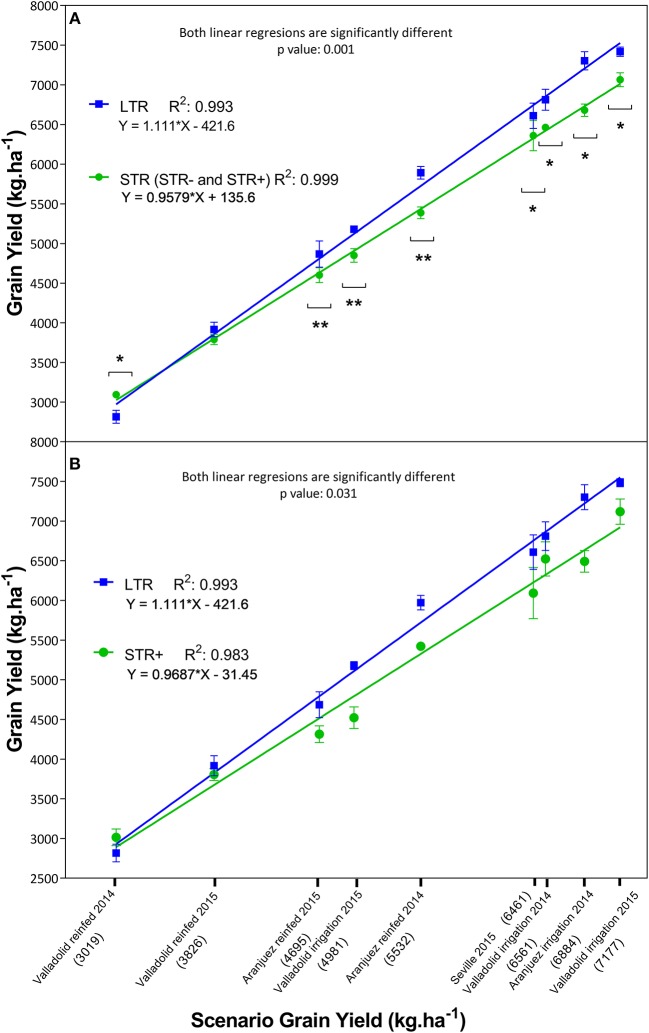
Grain yield differences between the segmented transpiration (STR: including less segmented transpiration, STR−and very segmented transpiration, STR+) and linear transpiration (LTR) lines across nine different growing conditions in the field. The X-axis presents the mean yield values of the complete set of 20 lines within each of the 9 trials where the mean yield across lines is expressed within parentheses below the name of the trial, while the Y-axis exhibits the mean yield of each subset of lines. In (A) the linear regressions represent the grain yield of the LTR (blue squares) and STR (green circles) groups within each growing scenario. Asterisks indicate significant differences between the LTR and STR groups performed by ANOVA (*p < 0.05, **p < 0.01). In (B) the linear regressions represent the average grain yield of the complete set of STR+ and LTR lines. Each value represents the average of any of the two groups of lines, each line being the mean value of three biological replicates (plots) per growing condition (i.e., trial). The level of significance (p) between fitting lines as well as the determination coefficient (R2) and the equation of each line are also indicated next to each legend.